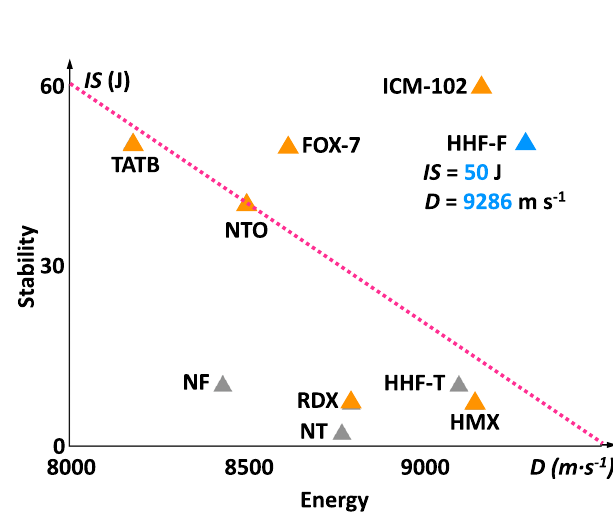
Fig.4|ThepropertiescomparisonofHHF-FwithotherHEDMs. Stability(impact sensitivity)andenergy(detonationvelocity(calculated))ofcompoundsNT,HHF-T, NF, HHF-F compared with TATB, RDX, NTO, FOX-7, ICM-102, and HMX.